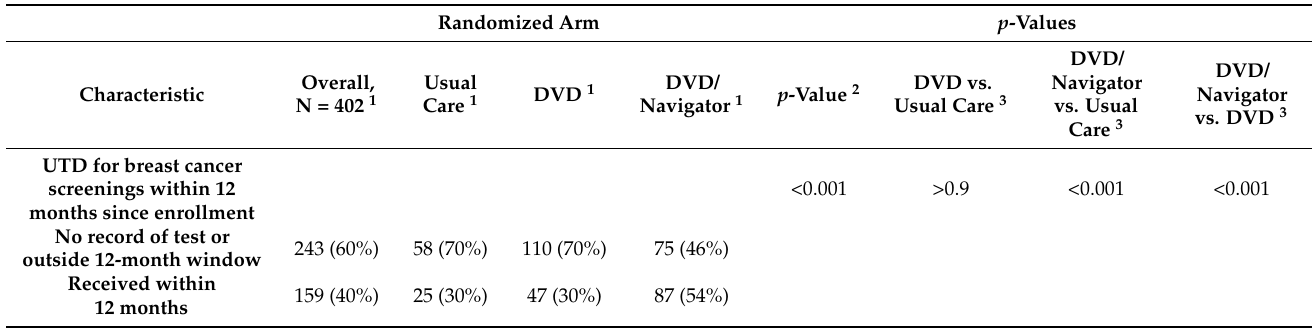
Table 2. Bivariate analysis of 12-month medical record breast cancer screening outcome by study arm (N = 402).